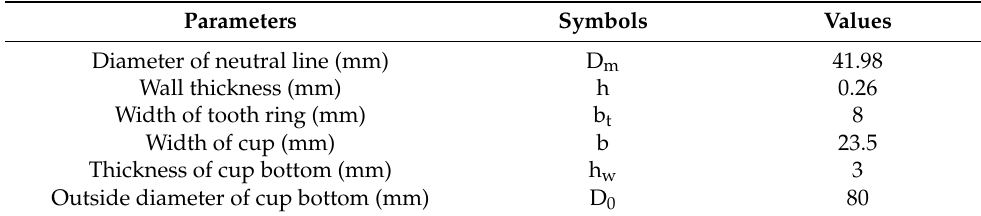
Table 1. The parameters of the